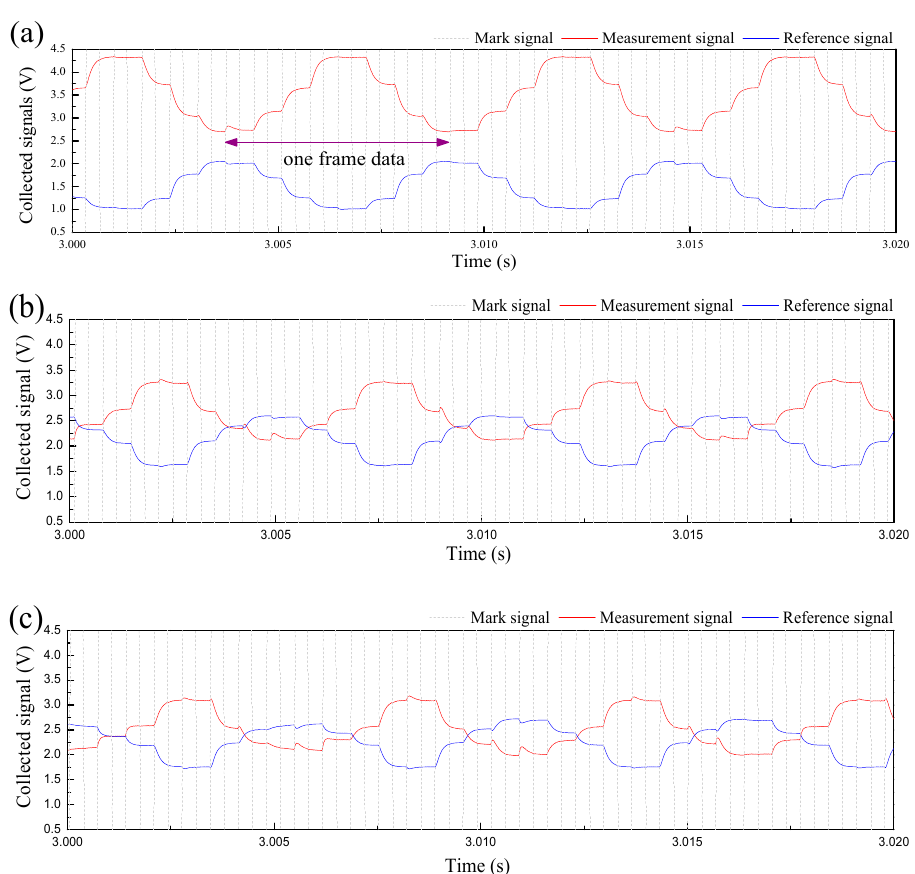
Figure 10. PLIF images for the flow conditions in the + 3 ◦ inclined pipe: ( a ) Usa = 0.052 m / s, Uso = 0.15 m / s, ST flow; ( b ) Usa = 0.222 m / s, Uso = 0.15 m / s, ST flow; ( c ) Usa = 0.393 m / s, Uso = 0.15 m / s, ST&MI flow.